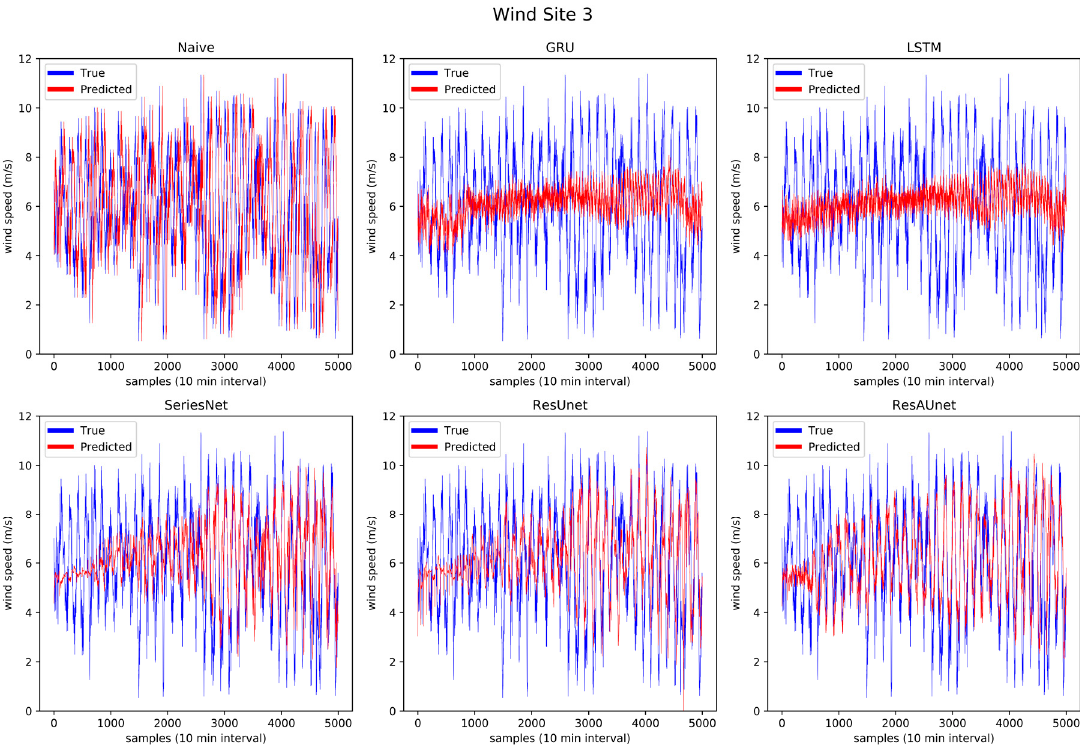
Figure 15. Prediction results of the six models for wind Site 3.